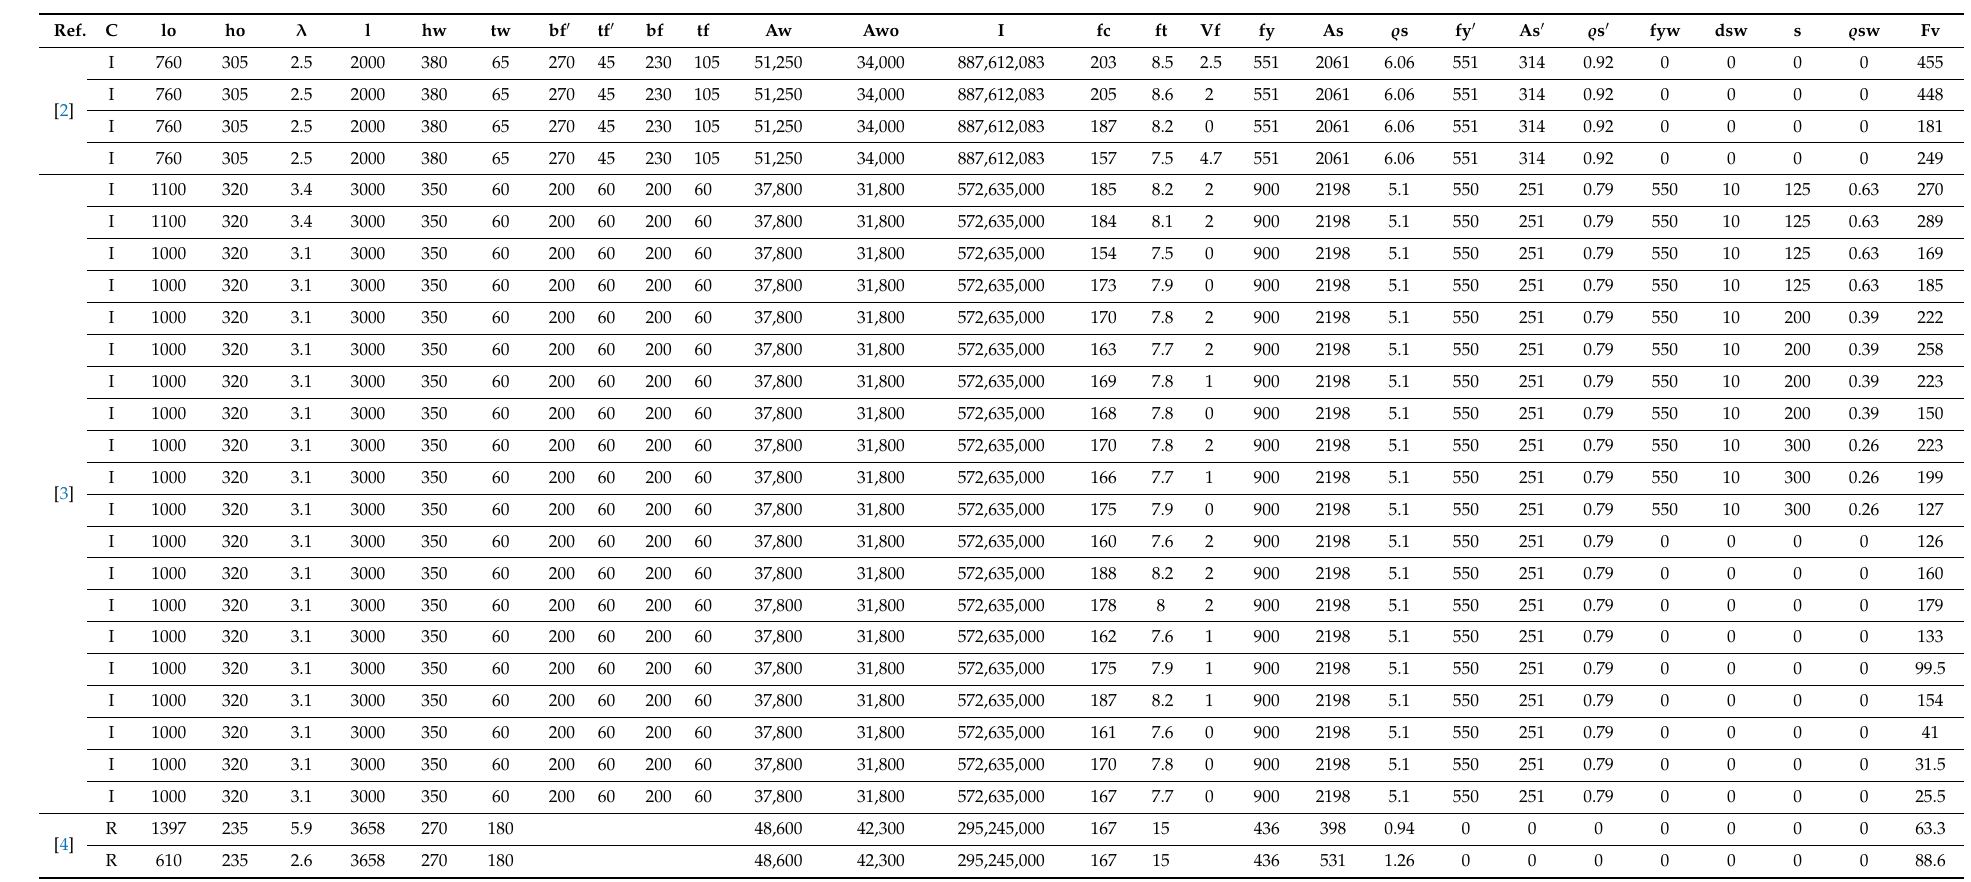
Table A1. Test data of UHPFRC beam